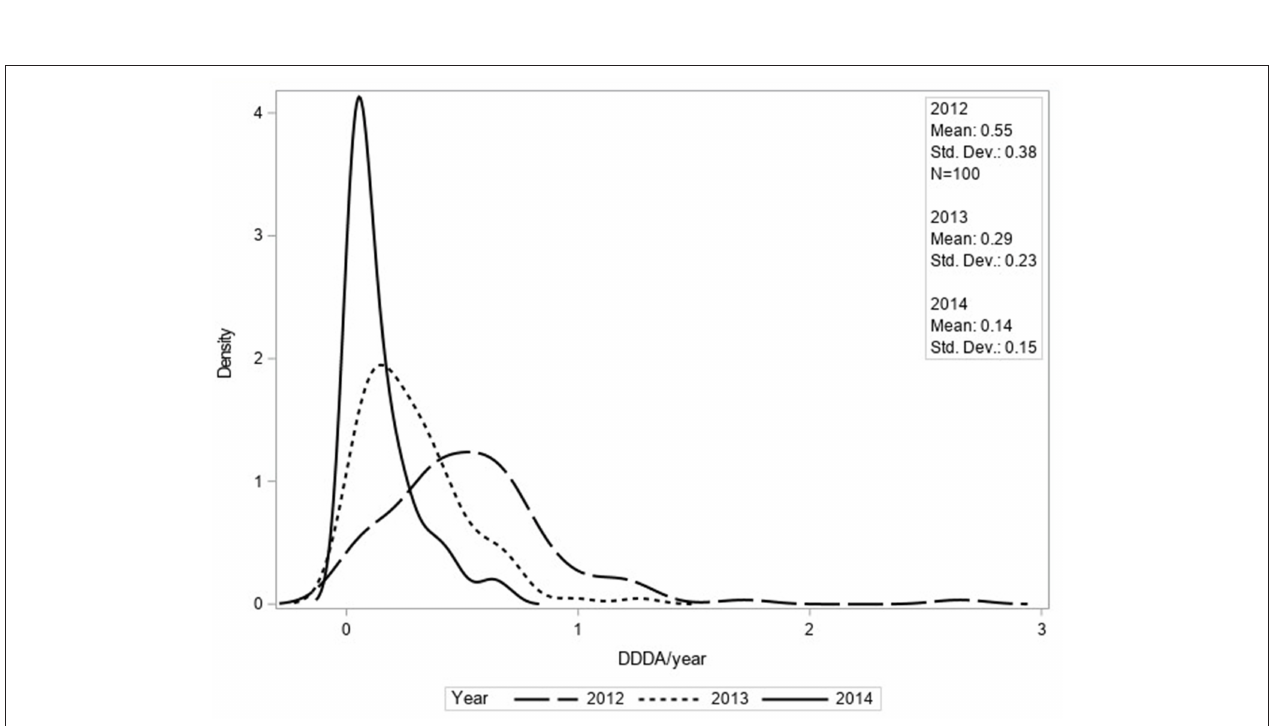
FIGURE 2 | Density function of DDDA CLINIC /year for third choice AMU based upon procurement data of 100 clinics for 2012, 2013, and 2014.